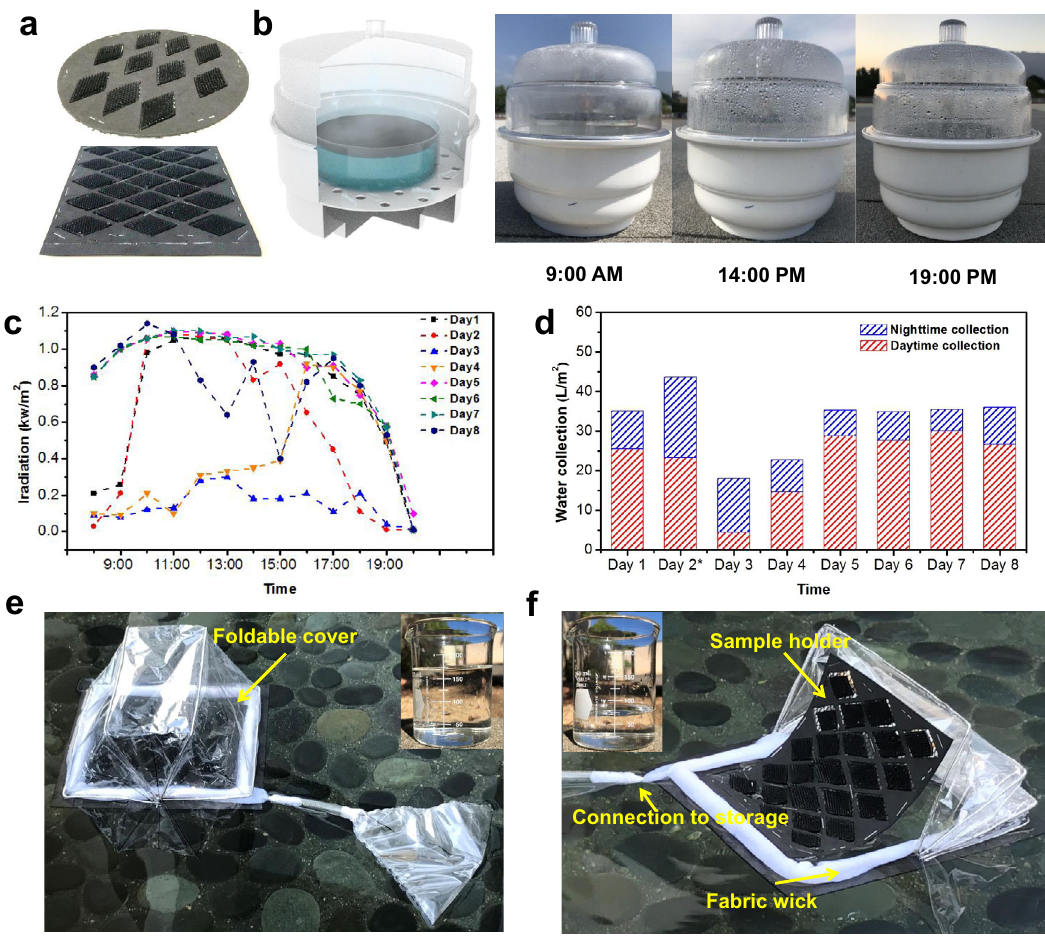
Fig. 5 All-day water harvesting by PVA/PPy gel micro-tree array outdoors. a Gel samples are held by a supporting structure made of polyurethane foam. b Schematic illustration and photos of a rooftop prototype acting as a solar water desalination system during daytime. c Solar radiation recorded during rooftop tests by portable solar power radiation meter. d Daily water collection per square meter of gel membrane during rooftop tests. Red: water collected during daytime (8 am – 8 pm); blue: water collected during nighttime (8 pm to next day ’ s 8 am). e Daytime and f nighttime modes of a fl oating